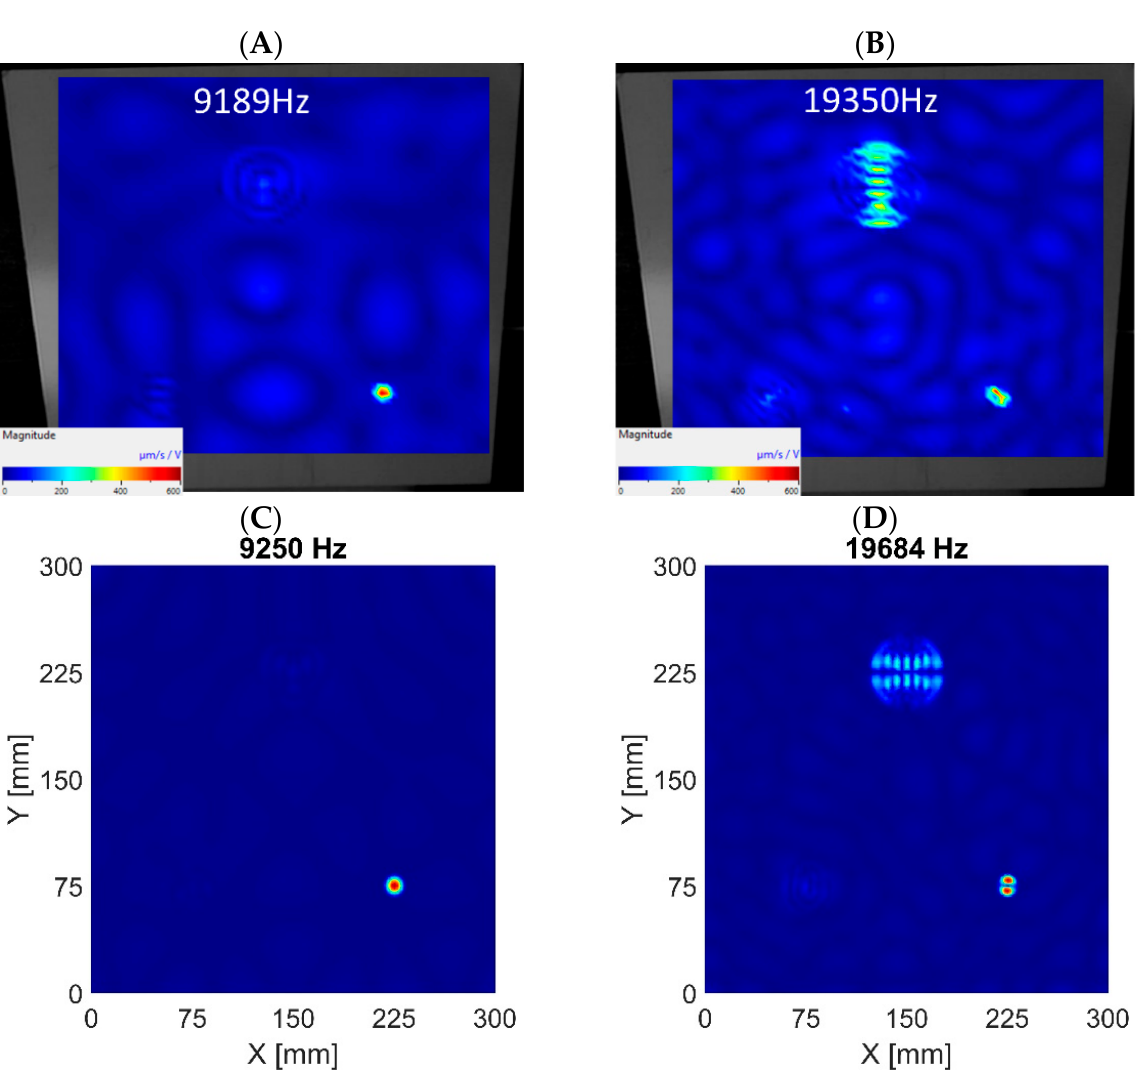
Figure 11. Visualization of out-of-plane vibrations—FBH Ø18 mm. The first LDR in experimental data ( A ) and numerical results based on the 3D FE model ( C ). The second LDR in experimental data ( B ) and numerical results based on the 3D FE model ( D ). Table 4. Comparison of out-of-plane LDRs frequencies detected by the algorithm for numerical models and experiments.